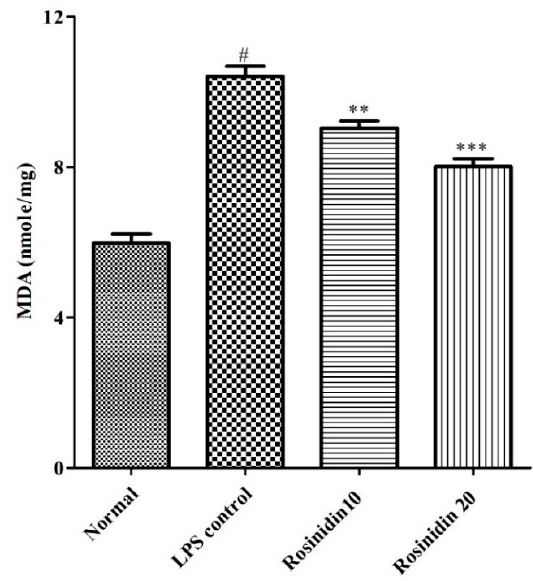
Figure 8. Effect of rosinidin on malondialdehyde levels in LPS-treated rats. Values are expressed as mean ± S.E.M. (n = 6). # p < 0.05 vs. normal control rats and ** p < 0.01 and *** p < 0.001 vs. LPS control rats. One-way ANOVA followed by Tukey’s post hoc test.